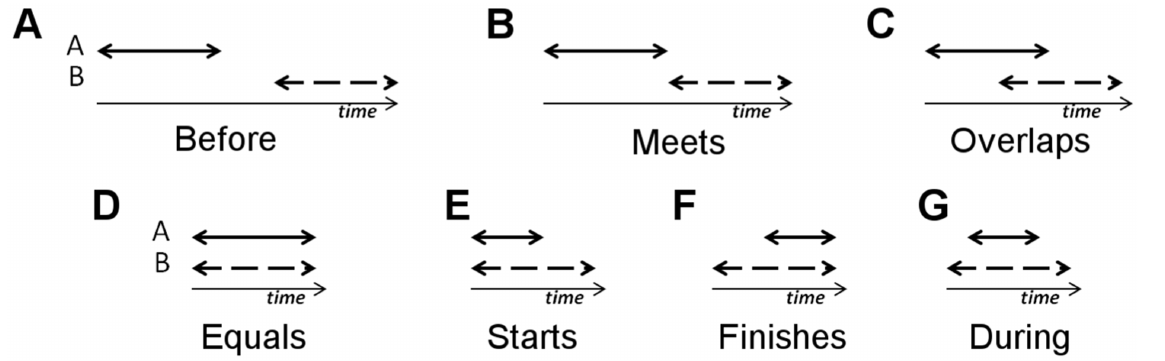
Figure 4. Visual representation of the propositions used in our coding.